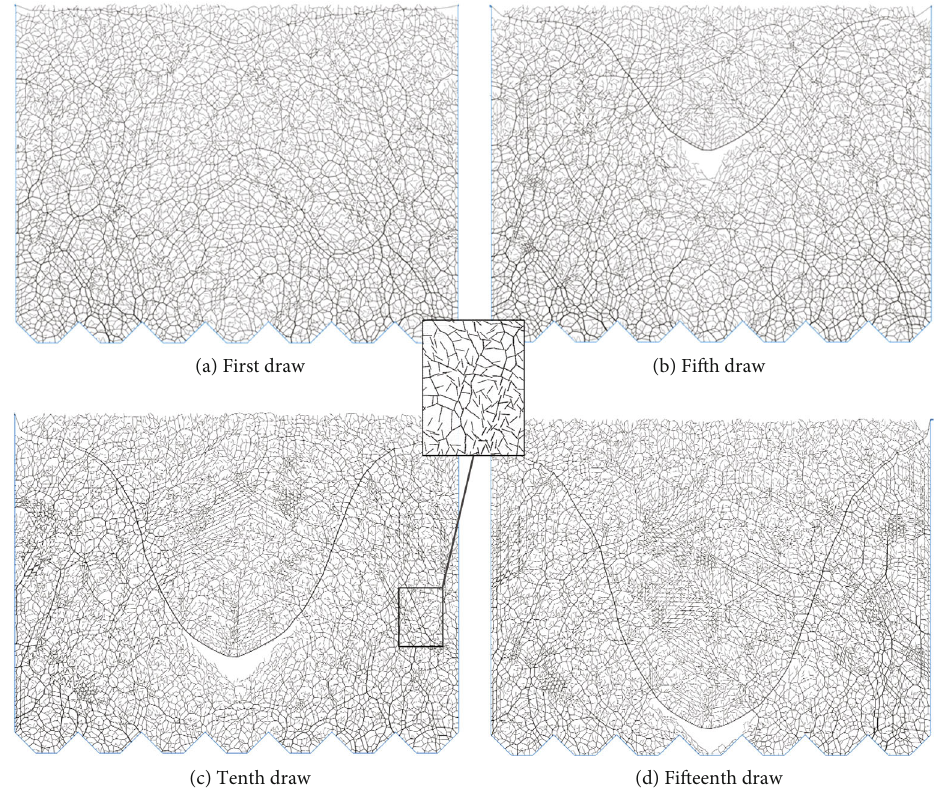
Figure 10: Morphological evolution law of the contact network during the ore drawing with a single drawpoint.